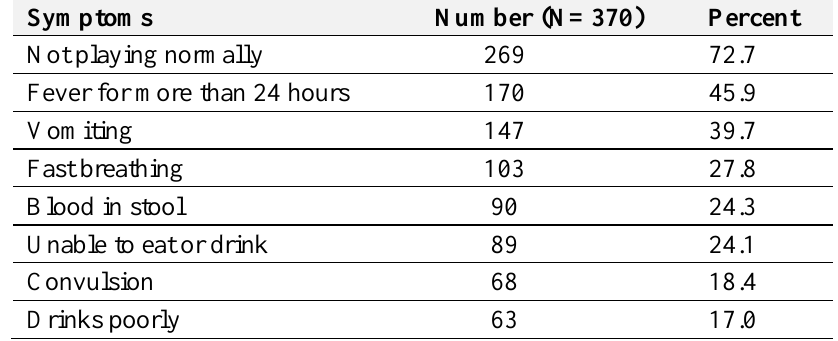
Table 1. Respondents’ correct knowledge of symptoms of illness in